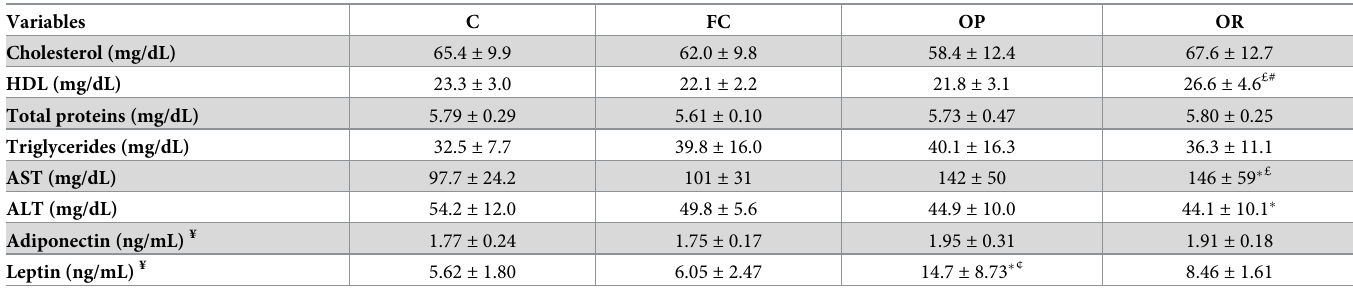
Table 2. Biochemical and hormonal